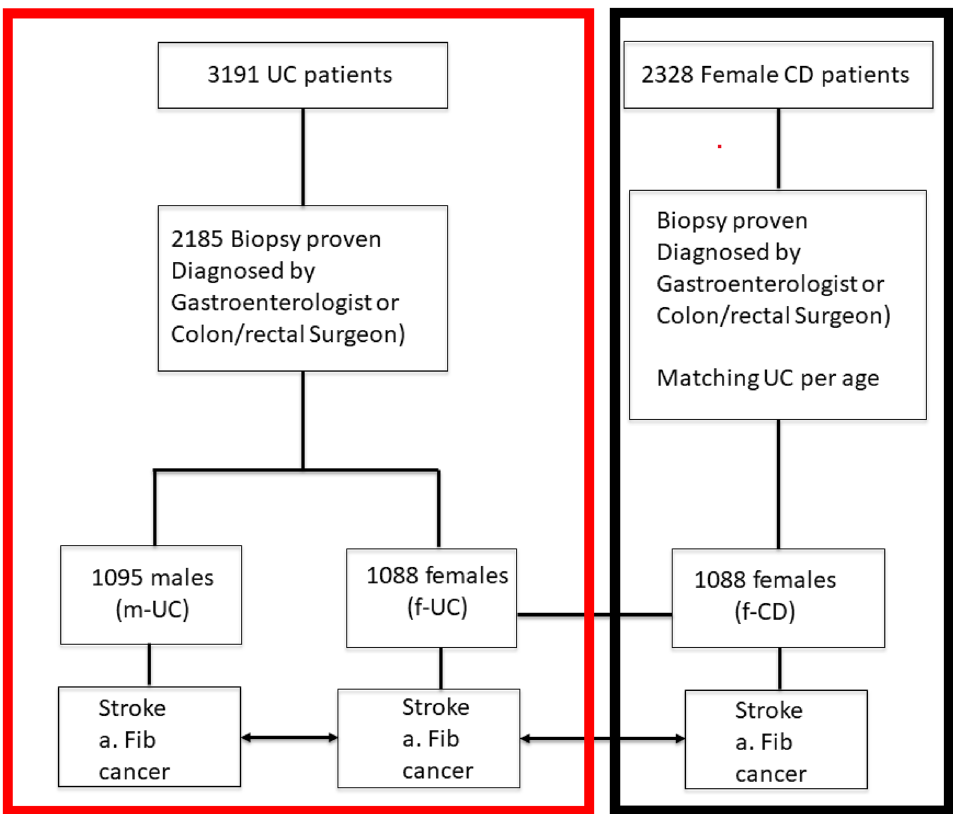
Figure 1. Patient selection and study design. A. Fib atrial fibrillation, CD Crohns disease, f-CD females with CD group, f-UC females with UC group, m-UC males with UC group, UC Ulcerative Colitis. (Red- Stage I) and Black (Stage 2).